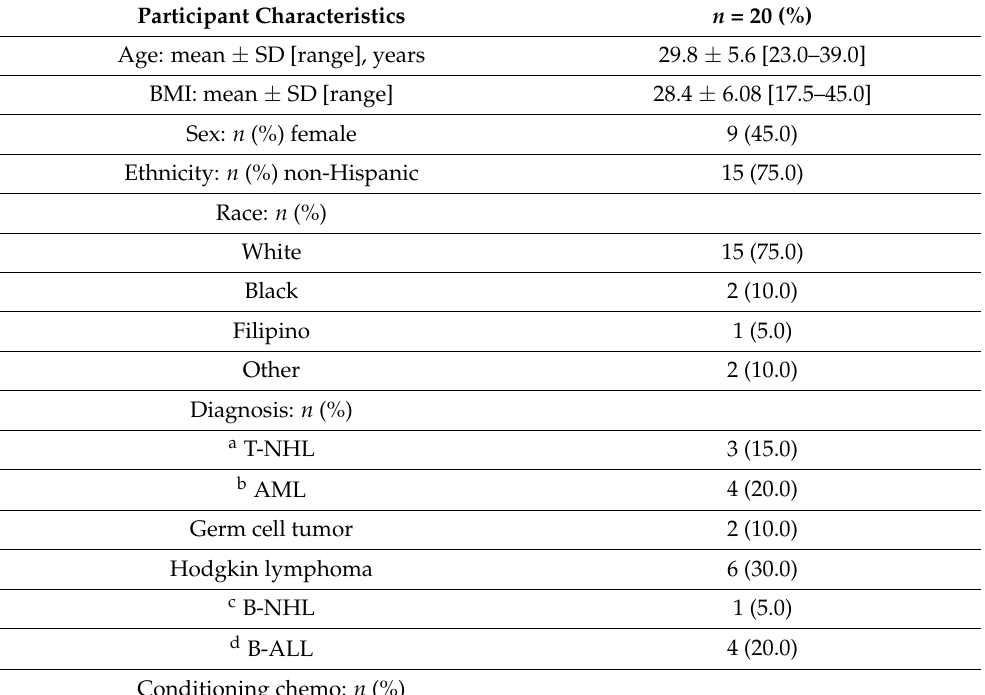
Table 1. AYA HSCT participant